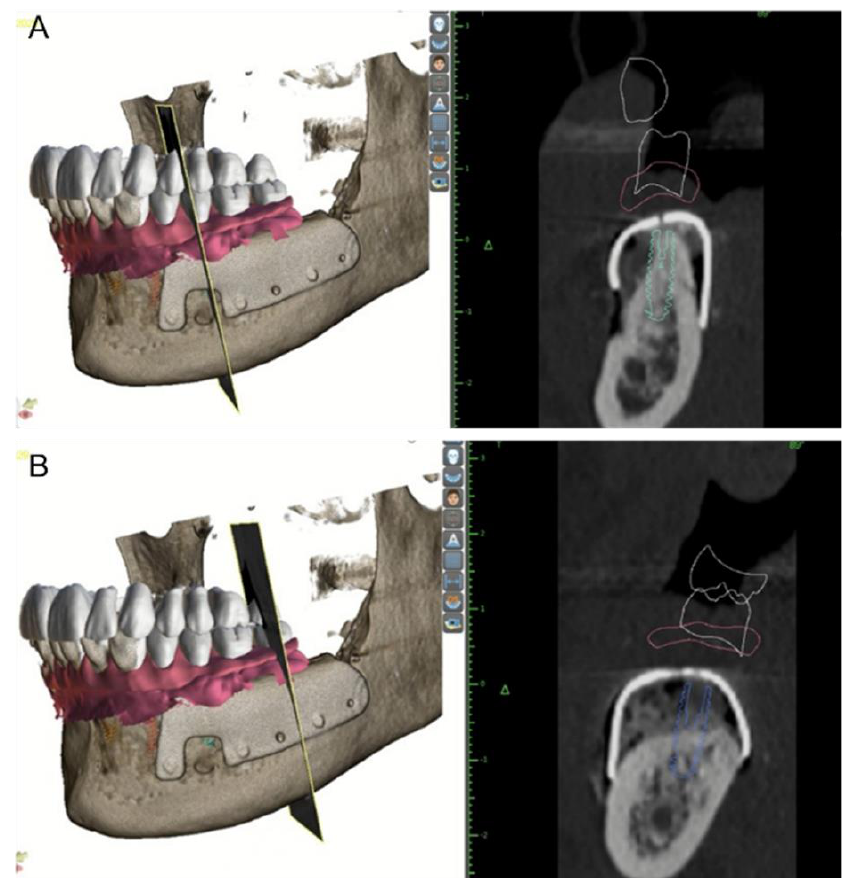
Figure 8. The cross−section CBCT images relative to the second premolar ( A ) and second molar Figure 8. The cross − section CBCT images relative to the second premolar ( A ) and second molar implant location ( B ) in the first case after a month of healing . implant location ( B ) in the first case after a month of